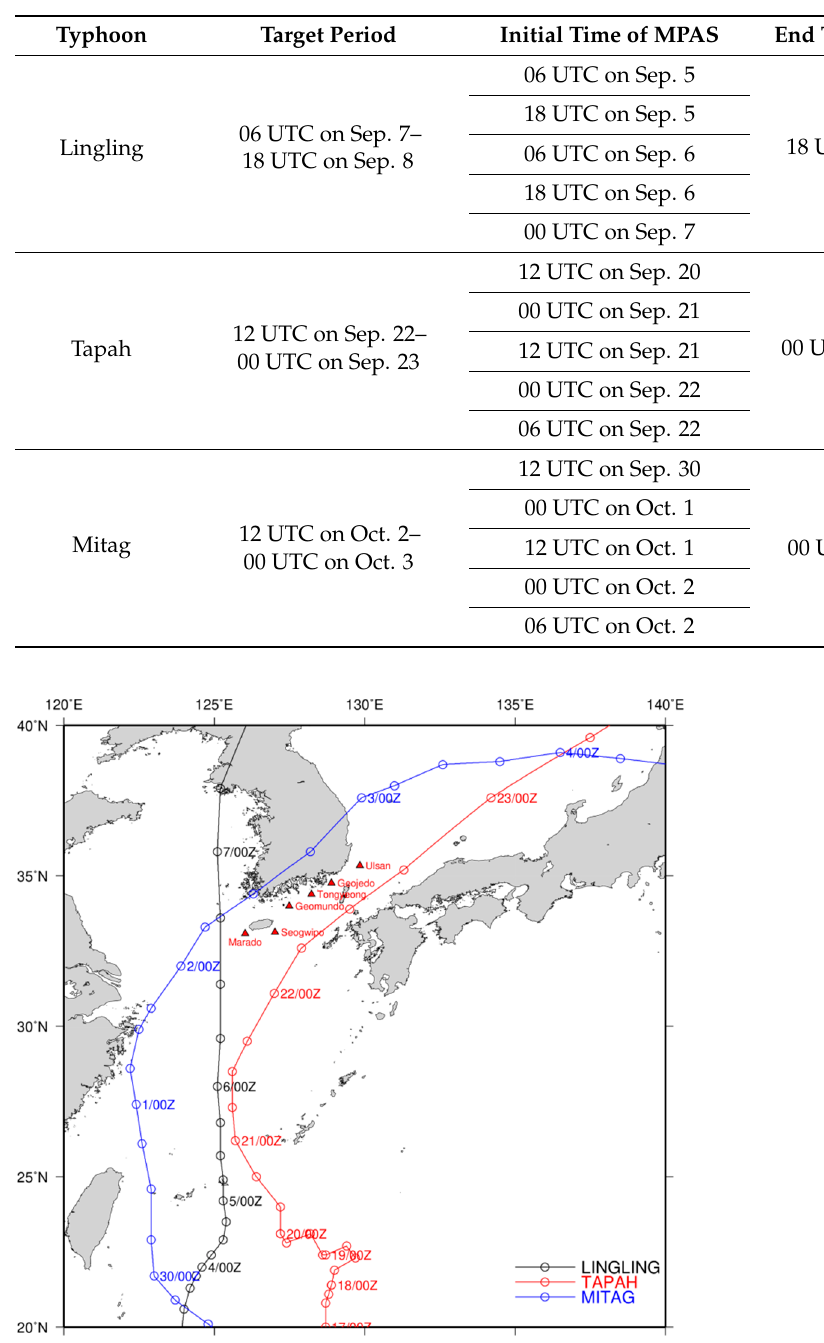
Table 2. List of three selected typhoons that occurred in 2019 and their MPAS simulation periods for the target periods.